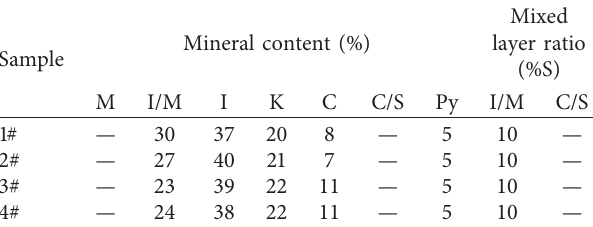
Table 5: X-ray diffraction analysis of clay minerals.